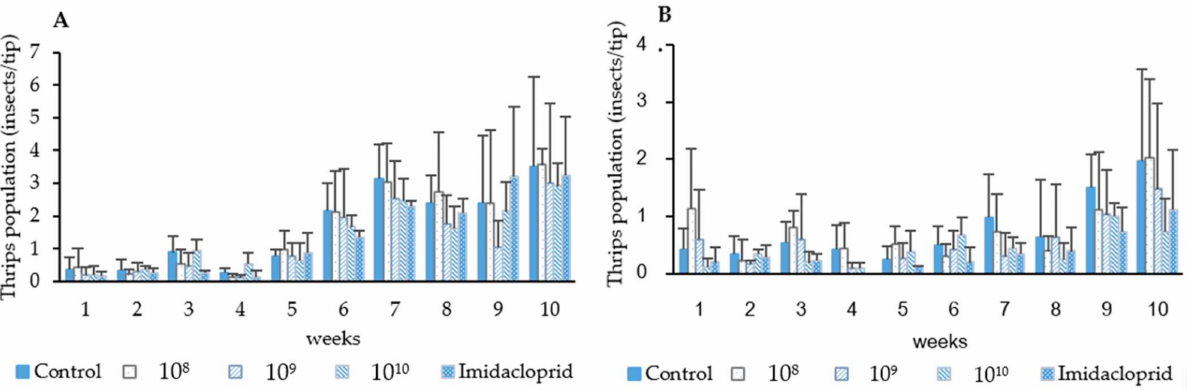
Figure 4. Effect of P. lilacinum TBRC10638 and imidacloprid on chili thrips ( S. dorsalis ) populations during the first ( A ) and second trial ( B ). Table 5. Control efficiency and chili yield (Kg/rai) of the chili plots sprayed with P.